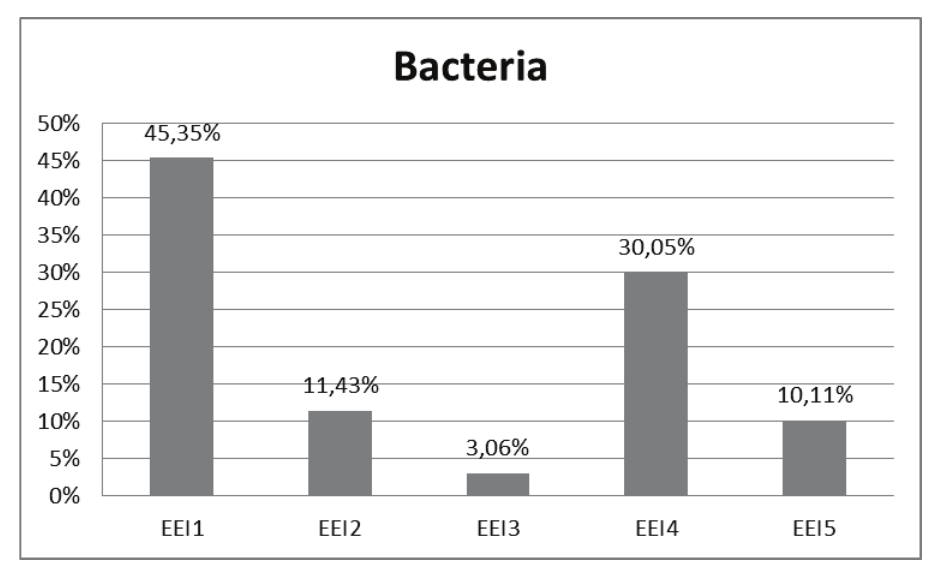
Fig. 4. Distribution of 2,582 Bacteria genomes to five types of the EEI.